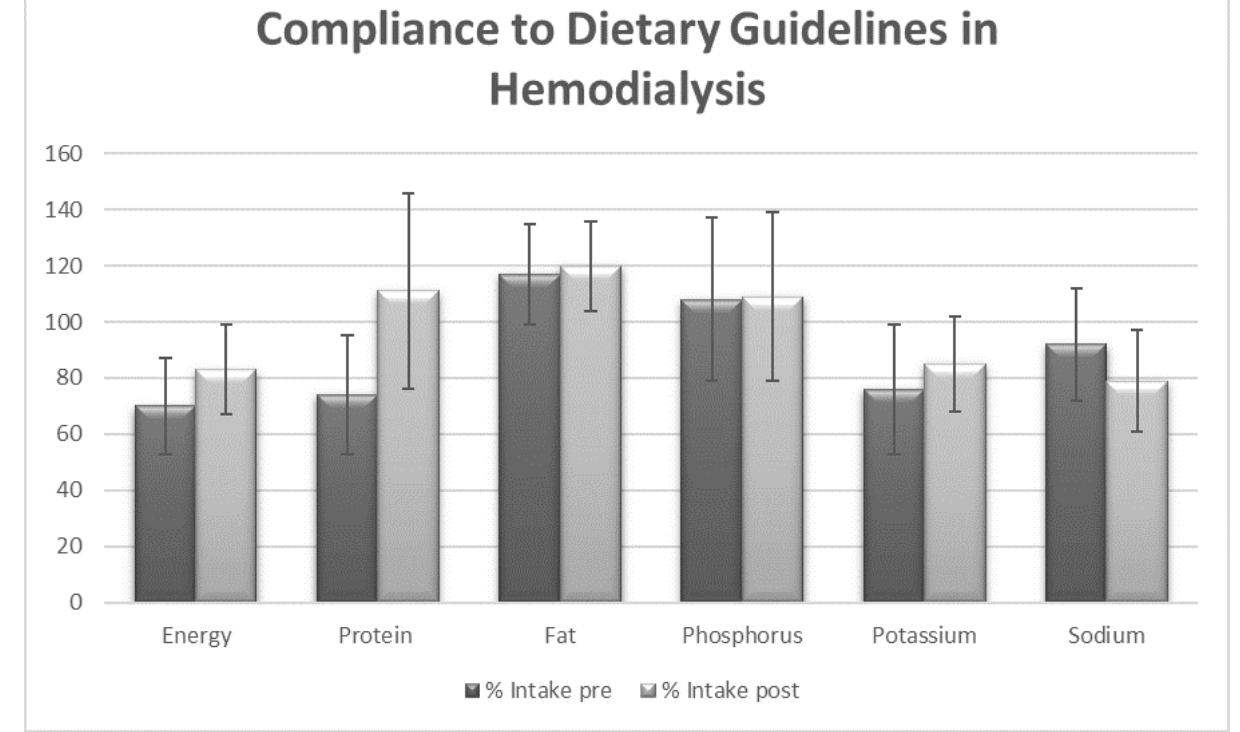
Figure 3. Percent (%) adherence to dietary intakes pre- and post-intervention. Values are presented as mean